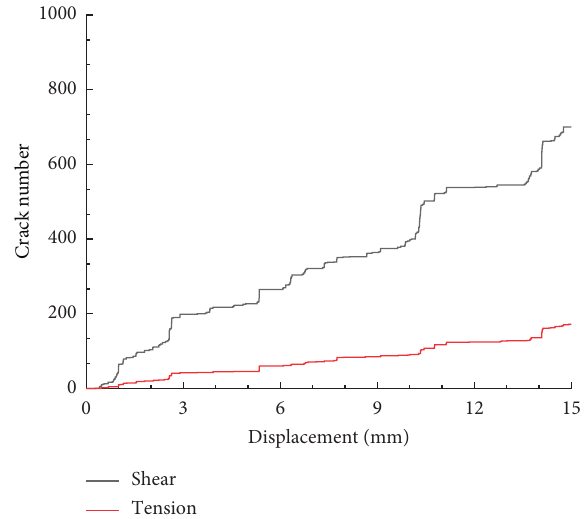
Figure 4: Number of cracks in the rock-breaking process of the disc cutter.